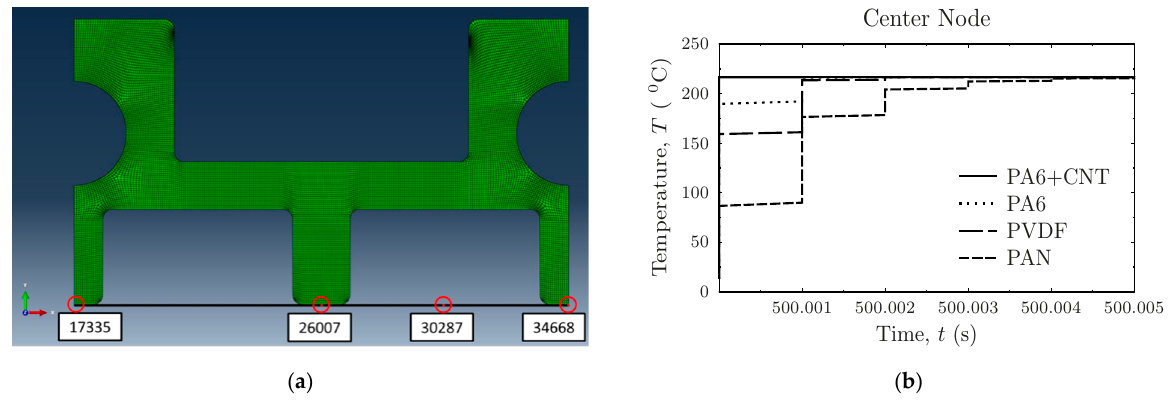
Figure 7. ( a ) Sampling nodes for analysis of nanofabrics. ( b ) Transient heat transfer at nanofabric node 26007. Table 3. Summary of material data used in the simulations.